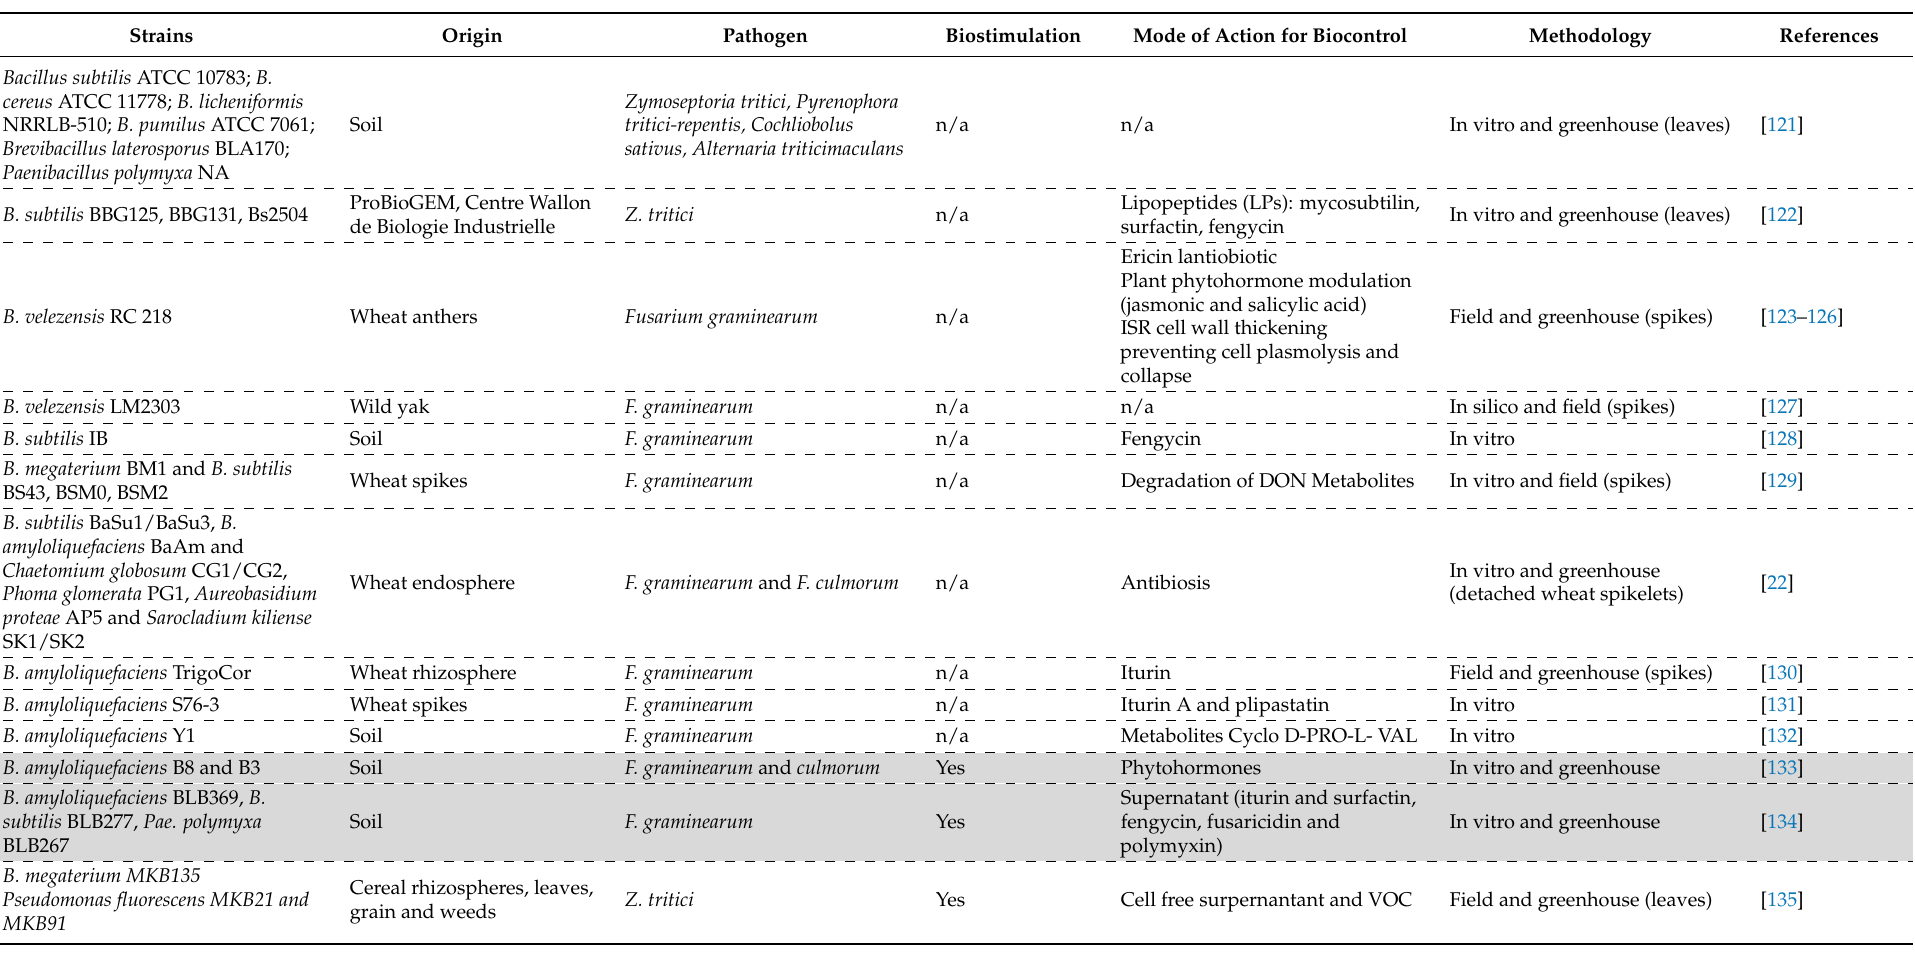
Table 2. Beneficial bacteria which demonstrated protection against main wheat pathogens. n/a: not